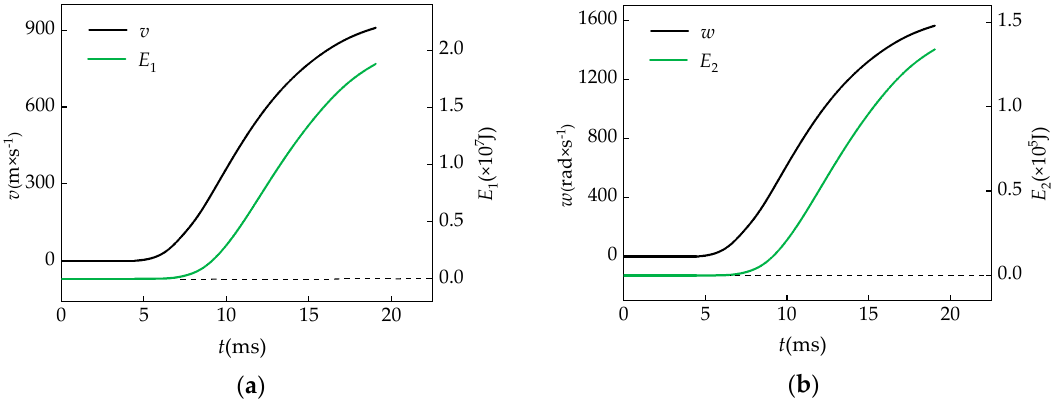
Figure 5. ( a ) Distribution of propellant gas pressure; ( b ) projectile bottom pressure.